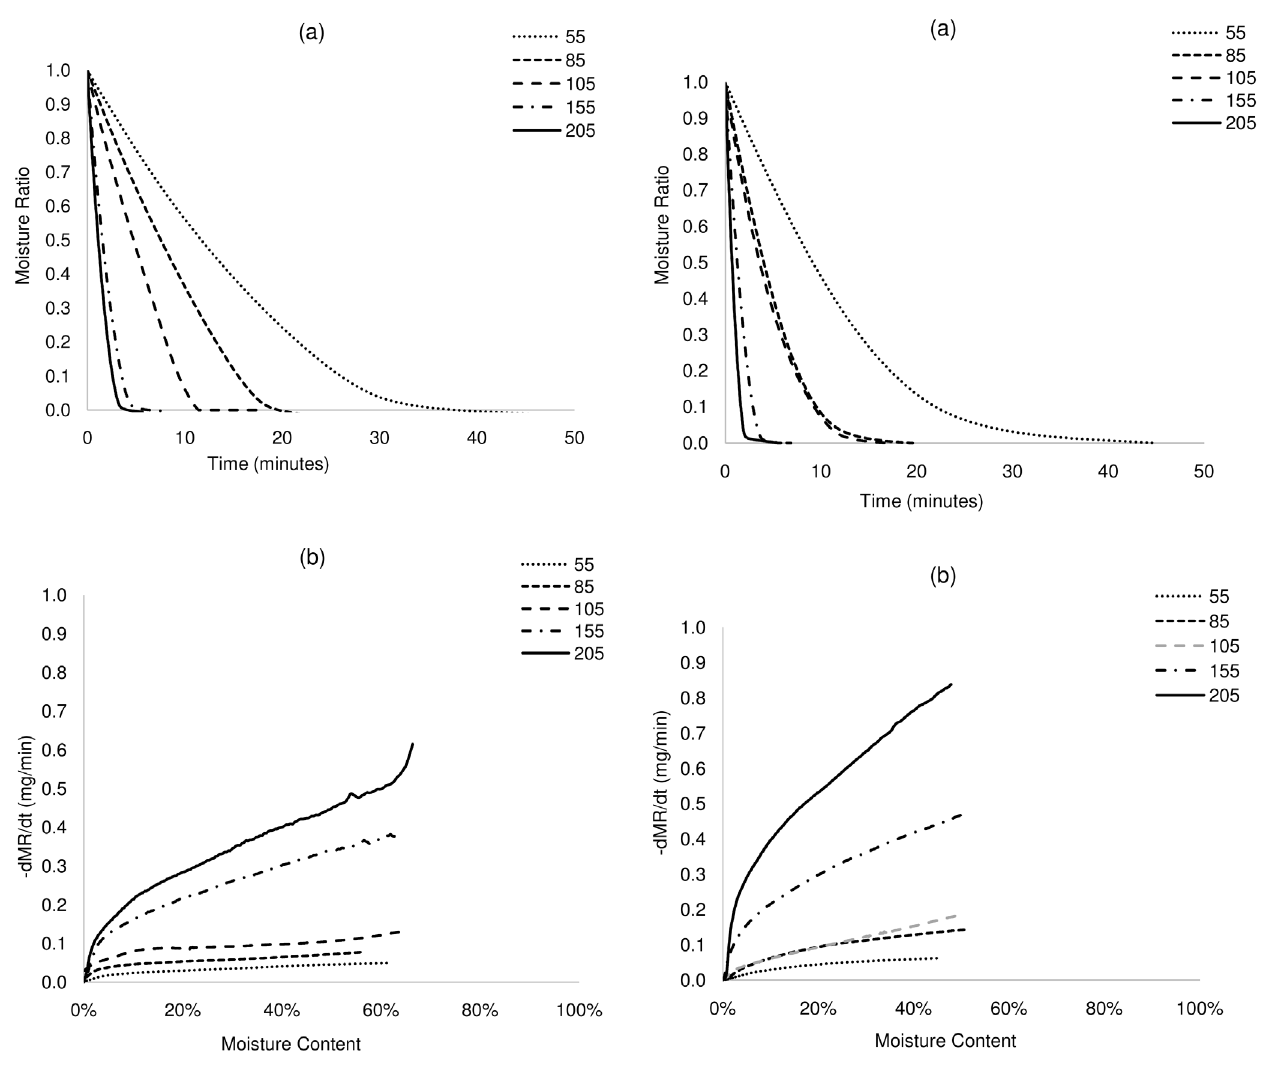
Figure 4. Isothermal drying curves of UDDT at 55 – 205°C. a ) MR versus time, b ) drying rate versus moisture content. UDDT, urine-diverting dry toilet.